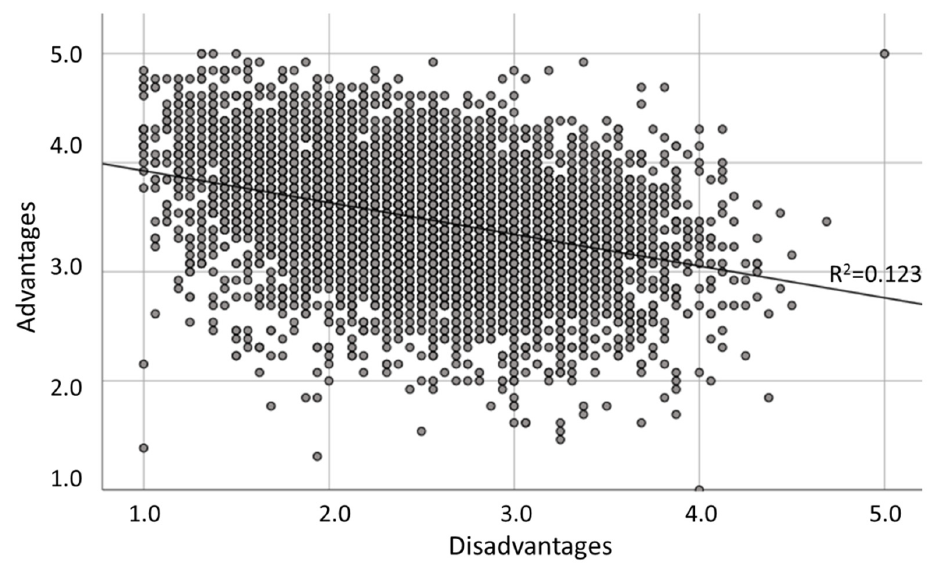
Figure 1. Positive (advantages) versus negative (disadvantages) working from home experience scores.